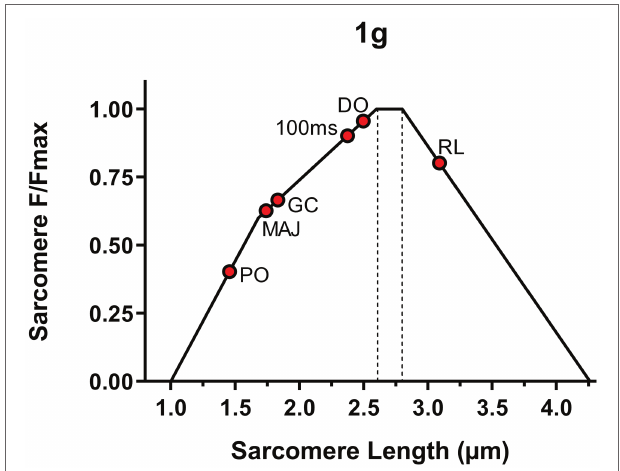
FIGURE 12 | Operating sarcomere length in its length-tension (L-T) relationship during the five different drop jump time points in 1 g. L-T relationship graphs adapted from Walker and Schrodt